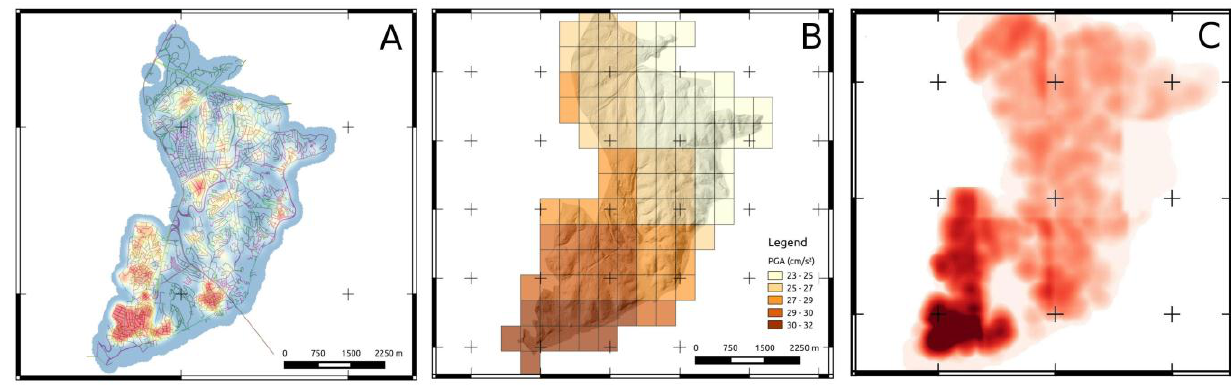
Figure 7. Computation of pre-event focus map. ( A ) spatial distribution of buildings weighted with related number of earthquake policies. ( B ) expected seismic hazard (PGA) with exceedance probability of 10% in 50 years. ( C ) resulting focus map obtained by linear pooling of the normalized layers with weights